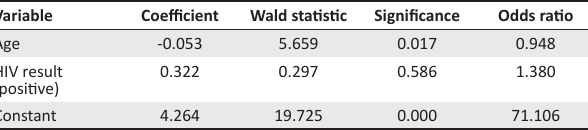
TABLE 2: Logistic regression of malignancy at age and HIV results. Variable